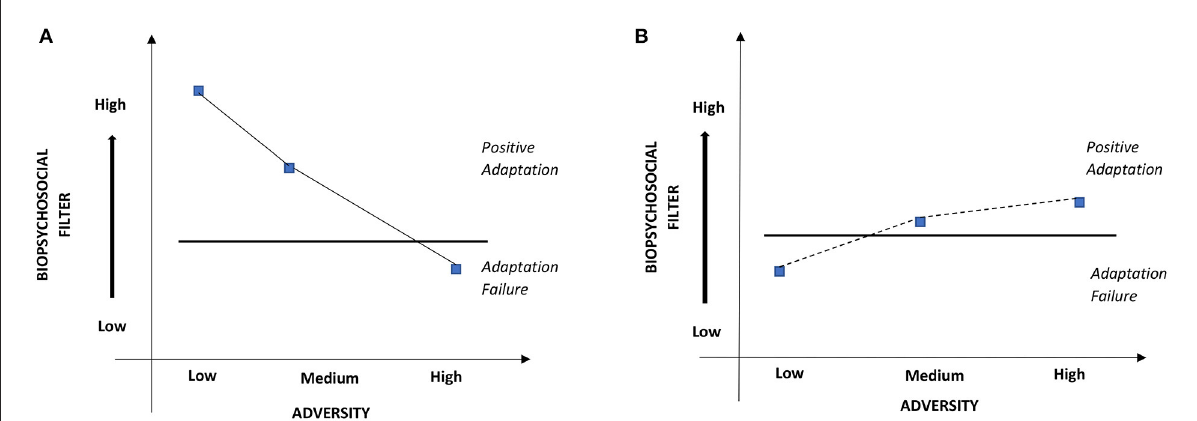
FIGURE2 Graphical model of adversity adaptation. Two examples of relationship between biopsychosocial filter strength, adversity intensity and resilience process. The left graph [Athlete (A) ] is an example of an athlete with various levels of protective resources interacting with adversities of different intensities. Athlete (A) engages resilience and positively adapts when filter is strong enough to handle adversity and has adaptation failure when high-intensity/acute adversity becomes too much for low biopsychosocial resources. The right curve [Athlete (B) ] is an example of a resilience response engaged over time relative to a matched adversity-biopsychological filter level where the athlete is engaged in a prolonged and iterative learning process. In the case of Athlete (B) , this is an example of emergent process-trajectory of resilience (hypothetical scenario mapped for pictorial